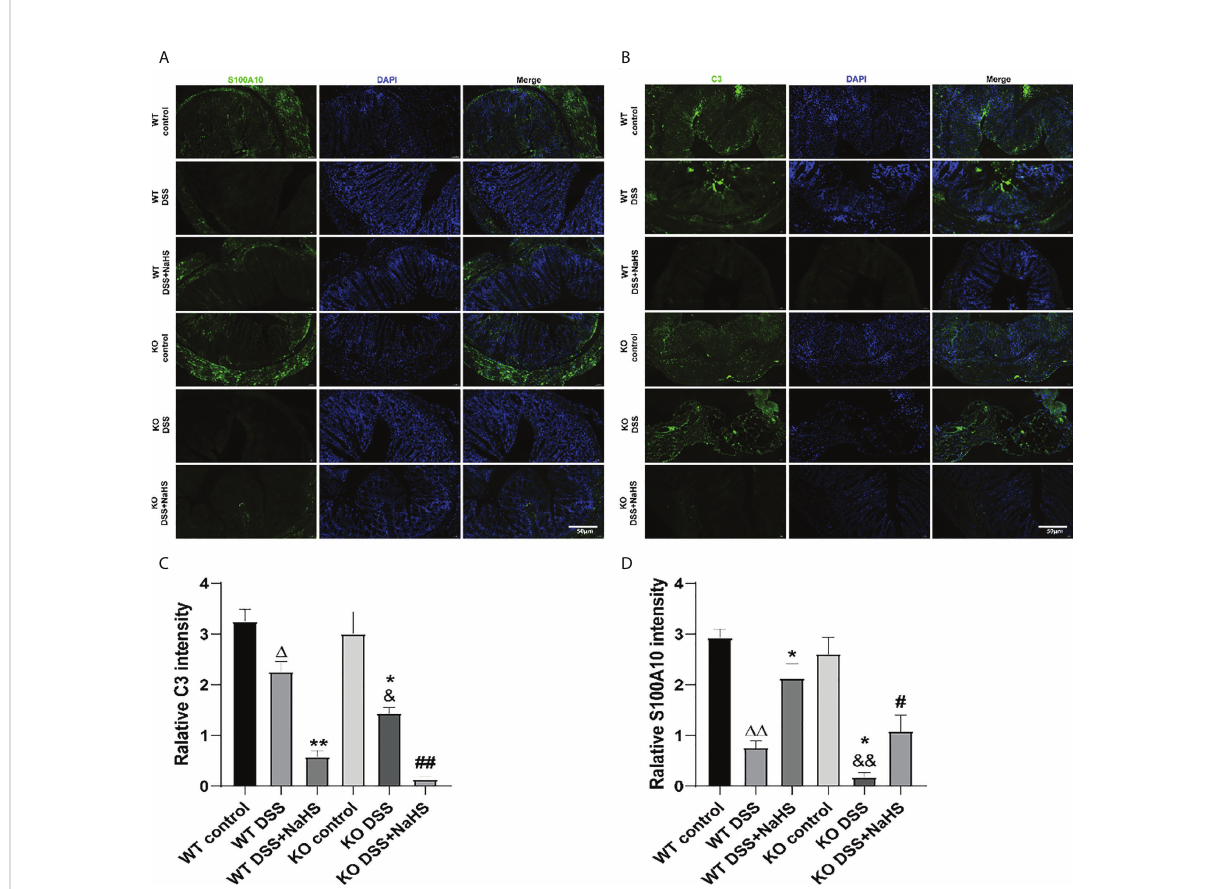
FIGURE 5 Effect of cystathionine- g -lyase (CSE)-produced hydrogen sul fi de (H 2 S) on the transformation of enteric glial cells (EGCs) from “ A1 ” to “ A2 ” in colon of mice after dextran sodium sulfate (DSS) (mean ± SEM, N=3). Scale bar=50 m m. (A) S100A10-positive cells are green, 4 ’ ,6-diamidino-2- phenylindole (DAPI) nuclear staining is blue (200×magni fi cation). (B) C3-positive cells are green, DAPI nuclear staining is blue (200×magni fi cation). (C) Relative S100A10 intensity in the colon of mice. (D) Relative C3 intensity in the colon of mice. D P < 0.05, DD P < 0.01 vs wild-type(WT) control group; *P < 0.05, **P < 0.01 vs WT DSS group; & P < 0.05, && P < 0.01 vs knockout(KO) control group; # P<0.05, ## P<0.01 vs KO DSS